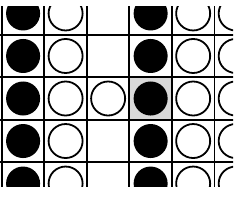
Figure 20. WHITE captures.